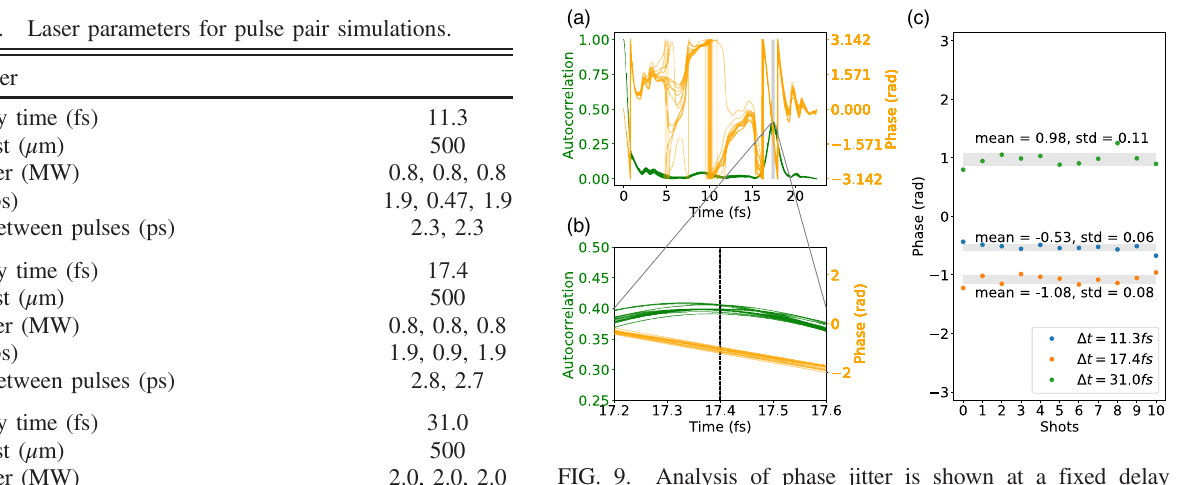
FIG. 9. Analysis of phase jitter is shown at a fixed delay between two pulses in the pulse pair. (a) The amplitude (green line) and phase (yellow line) of the autocorrelation are shown for the on-axis pulse pair radiation field with 17.3-fs delay, and (b) an enlarged view shows the correlation and relative phase between the pairs of pulses. (c) The relative phase between the pulse pairs is shown for 11 shots at delay times of 9.5 fs (blue), 17.3 fs (yellow), and 31.0 fs